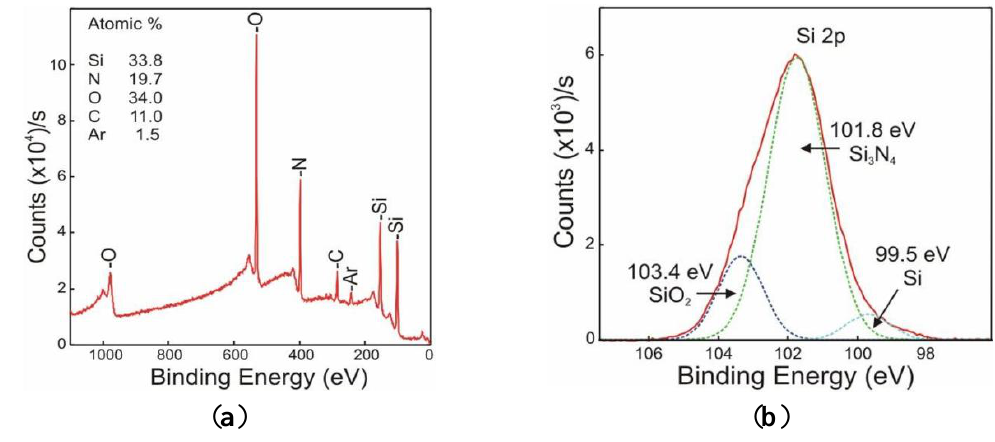
Figure 3. XPS spectra of the activated silicon nitride coated Optical Waveguide Lightmode Spectroscopy (OWLS) chip ( a ) full energy range spectrum and ( b ) high resolution spectrum of the Si 2p peak, showing its deconvolution into three contributions. After the chemical activation procedure with NaOH solution, a high content of O can be observed, which is in accordance with the presence of SiO 2